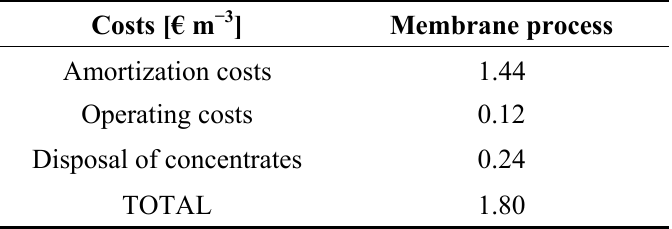
Table 6. Comparison of costs referred to 1 m 3 of treated tannery wastewater stream in